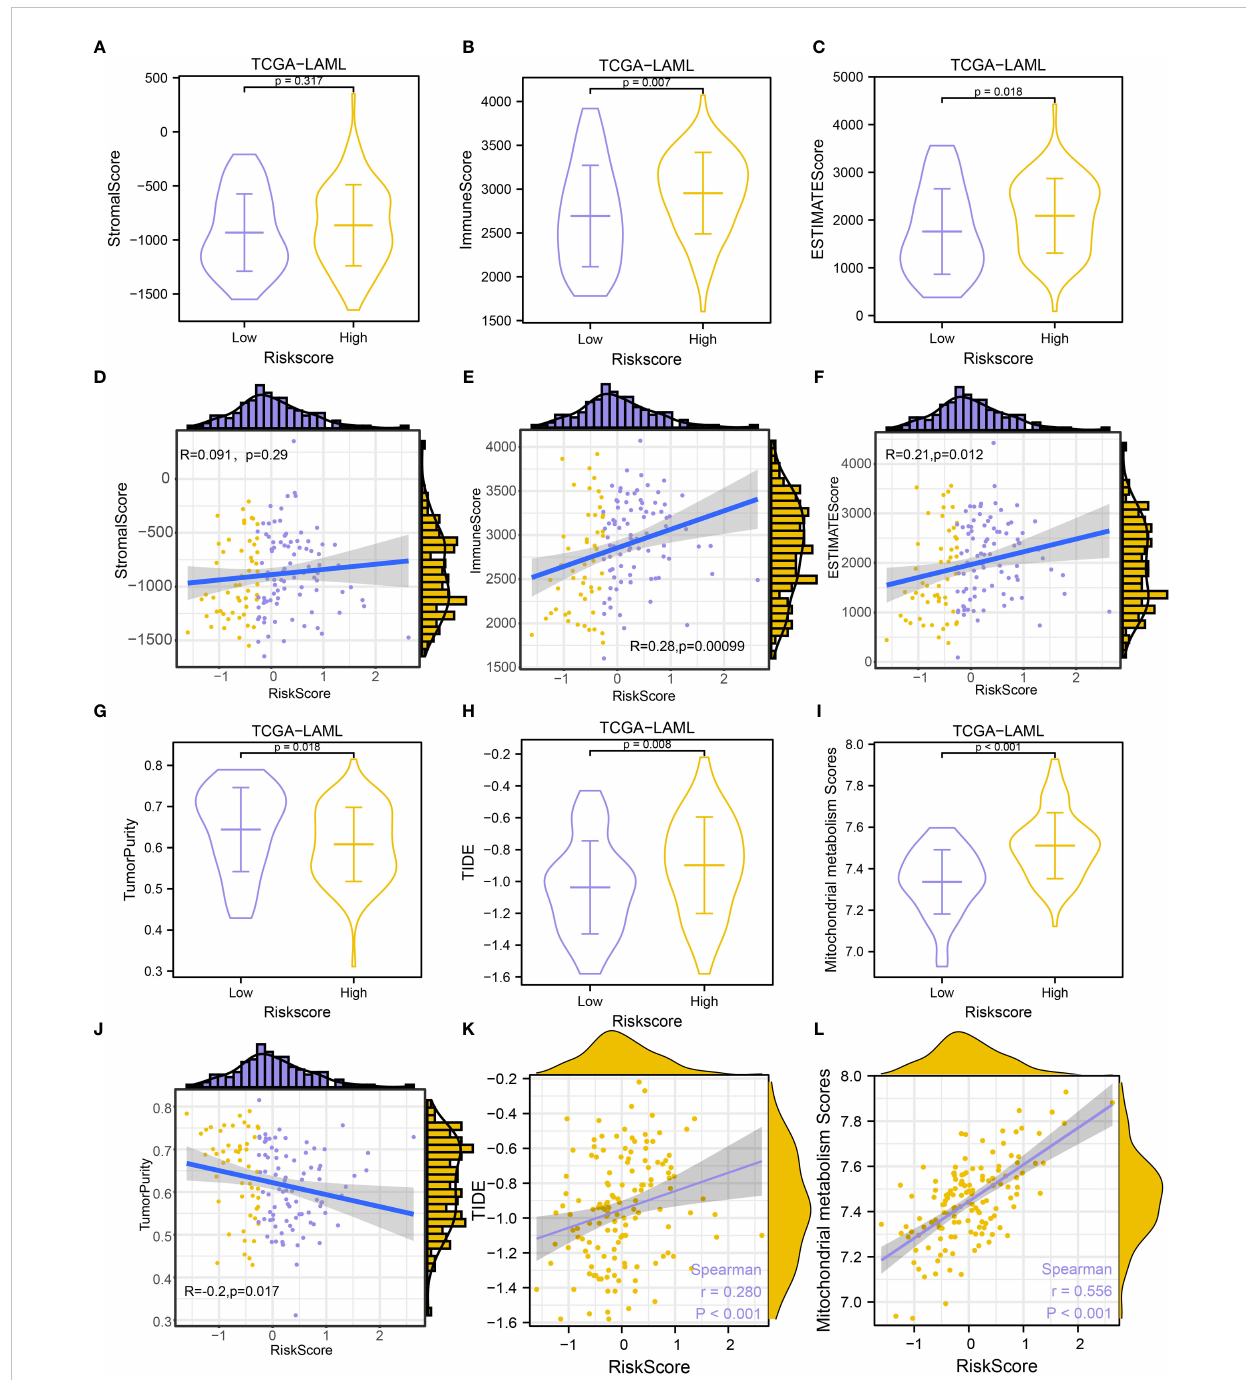
FIGURE 10 Immune in fi ltration estimation and correlation analysis. (A-C) . Comparison of StromaScore (A) , ImmuneScore (B) , and ESTIMATEScore (C) between groups. (D-F) . Scatterplots of the correlations between risk score and StromalScore (D) , ImmuneScore (E) , and ESTIMATEScore (F) . (G-I) . Comparison of Tumor Purity (G) , TIDE prediction score (H) , and MMs (I) between groups. (J – L) . Scatterplots of the correlations between risk score and Tumor Purity (J) , TIDE prediction score (K) , and MMs (L)